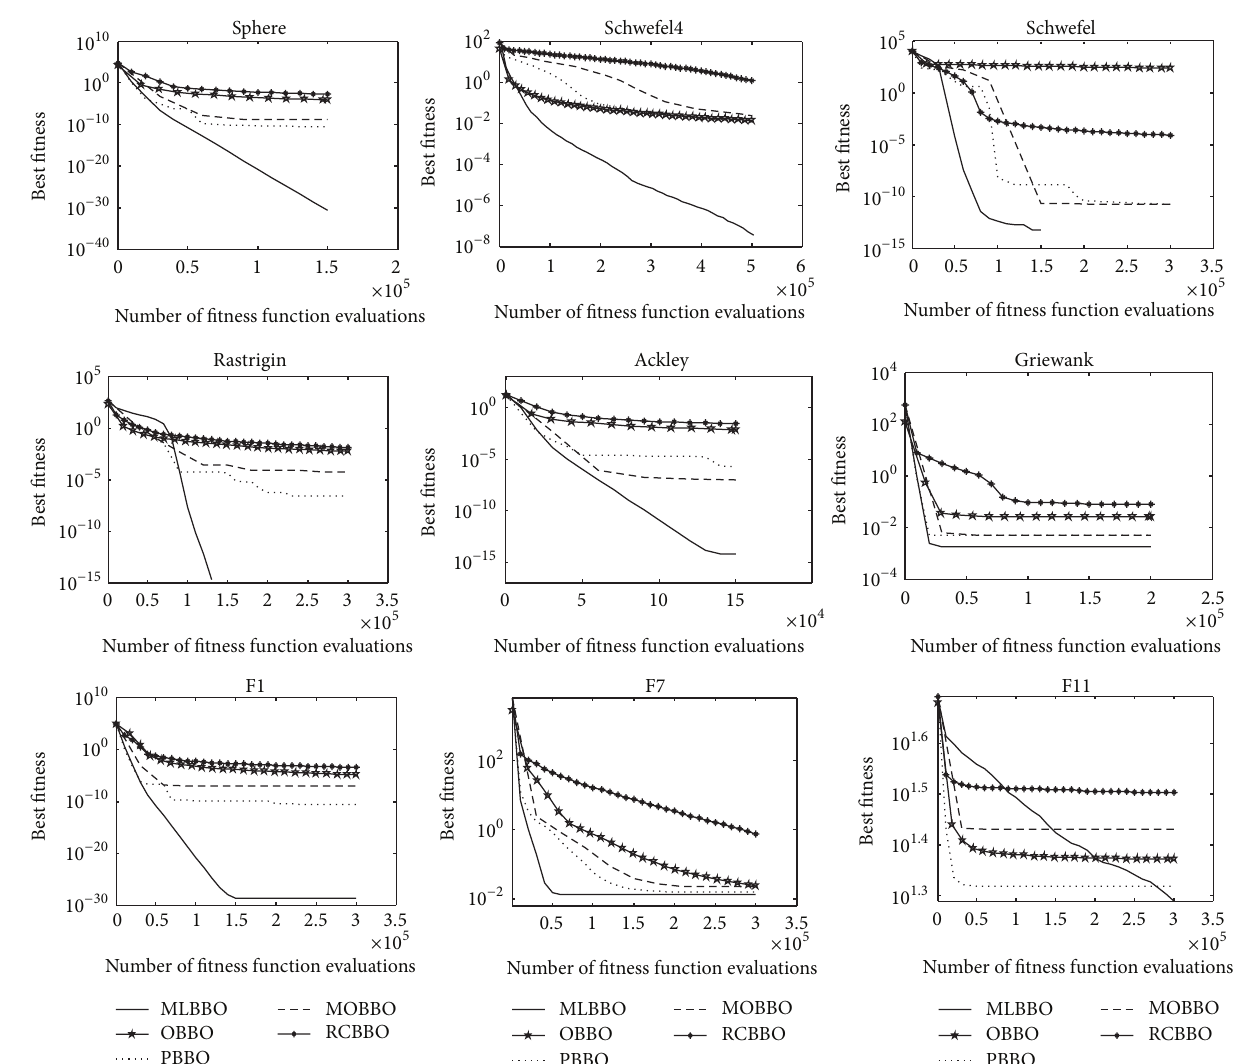
Figure 4: Convergence curves of mean fitness values of MLBBO, OBBO, PBBO, MOBBO, and RCBBO for functions f1, f4, f8, f9, f6, f7, f8, f9, f10, F1, F7, and